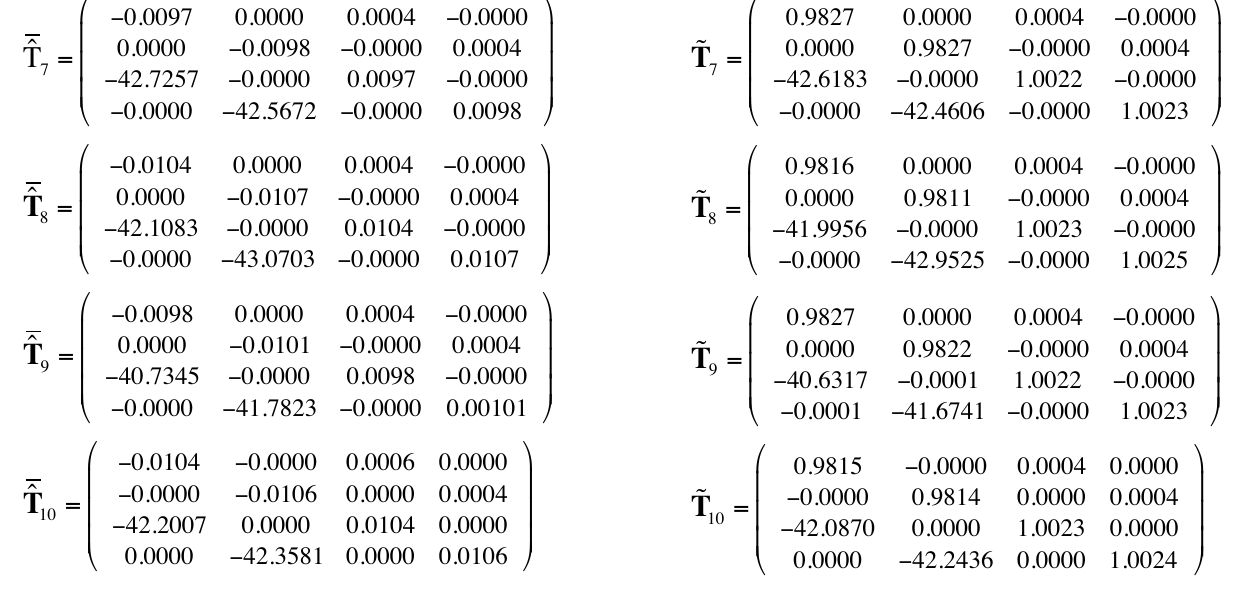
Table 2. Mean coordinate vectors ( ˆ v ) from transformed transferences of ten subjects. Subscripts from 1 to 10 are used to indicate the ten different subjects. In each vector, the first four entries are unit-less, the second three entries are in metres while the last three entries are in dioptres.